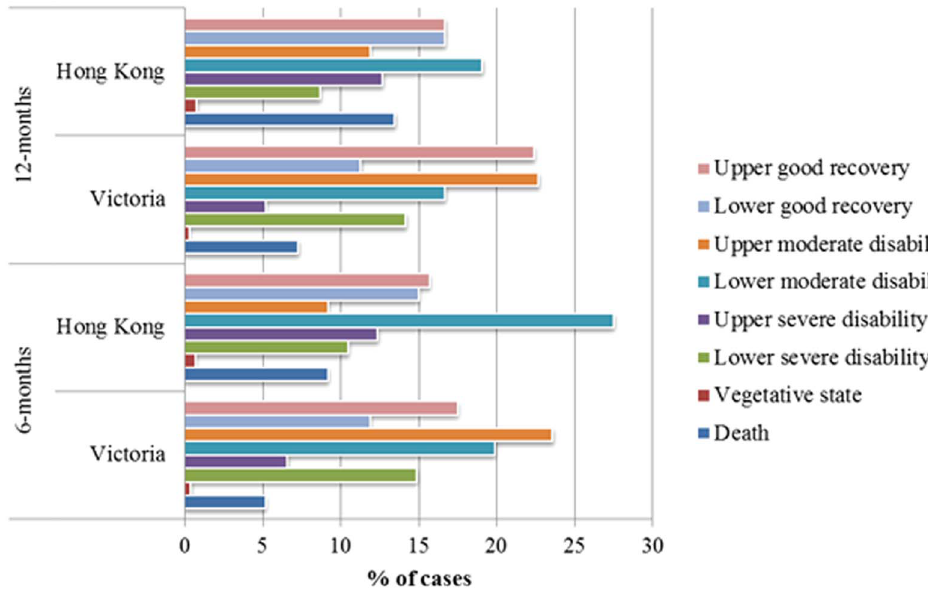
Figure 1. Distribution of GOS-E scores. This figure shows the distribution in GOSE scores between Hong Kong and Victoria.